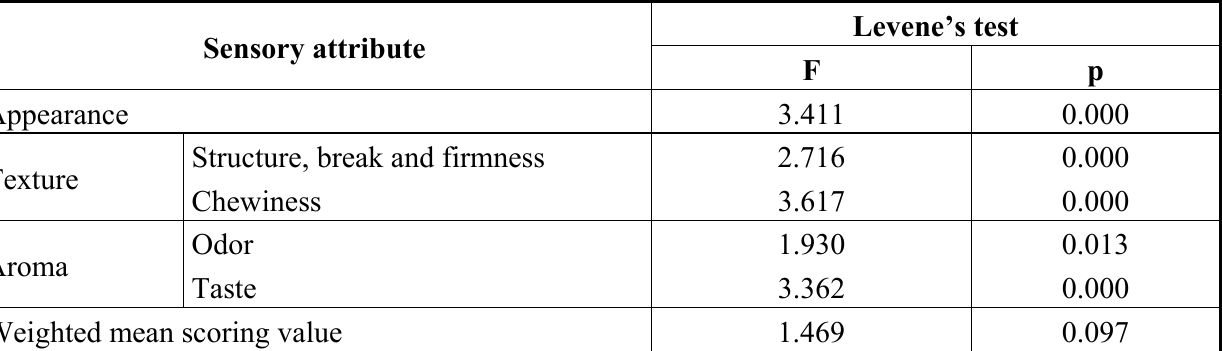
Table 3. Results of the Levene’s test of homogeneity of variances of dietary